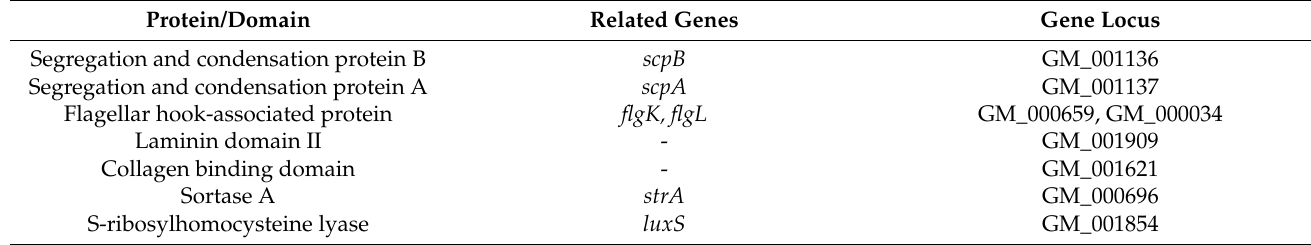
Table 5. Cell-adhesion-related proteins in the Lactococcus garvieae FUA009